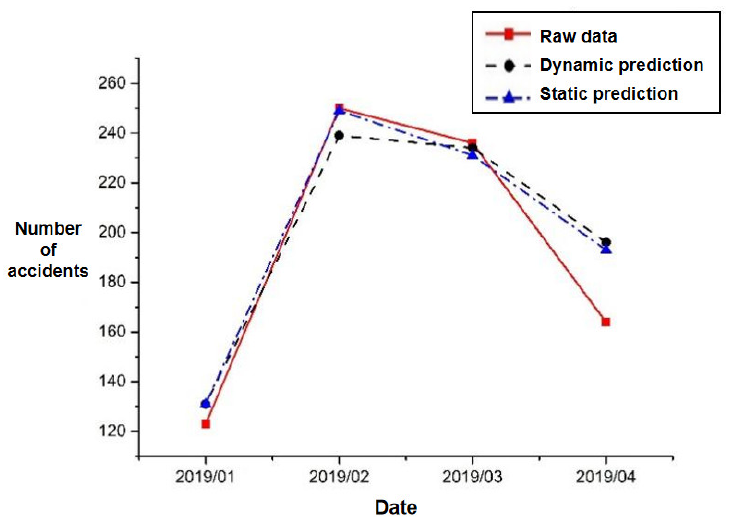
Figure 6. Quarterly forecast results of housing municipal engineering production safety accidents in 2019.